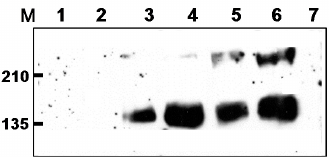
Figure 1. Expression of hFlex-gp102 in rMVA-infected cell lysates. Western blot analysis of DF-1cell lysates infected with rMVA expressing tPAhFlex-gp120 after probing with anti-hFlex antibody.